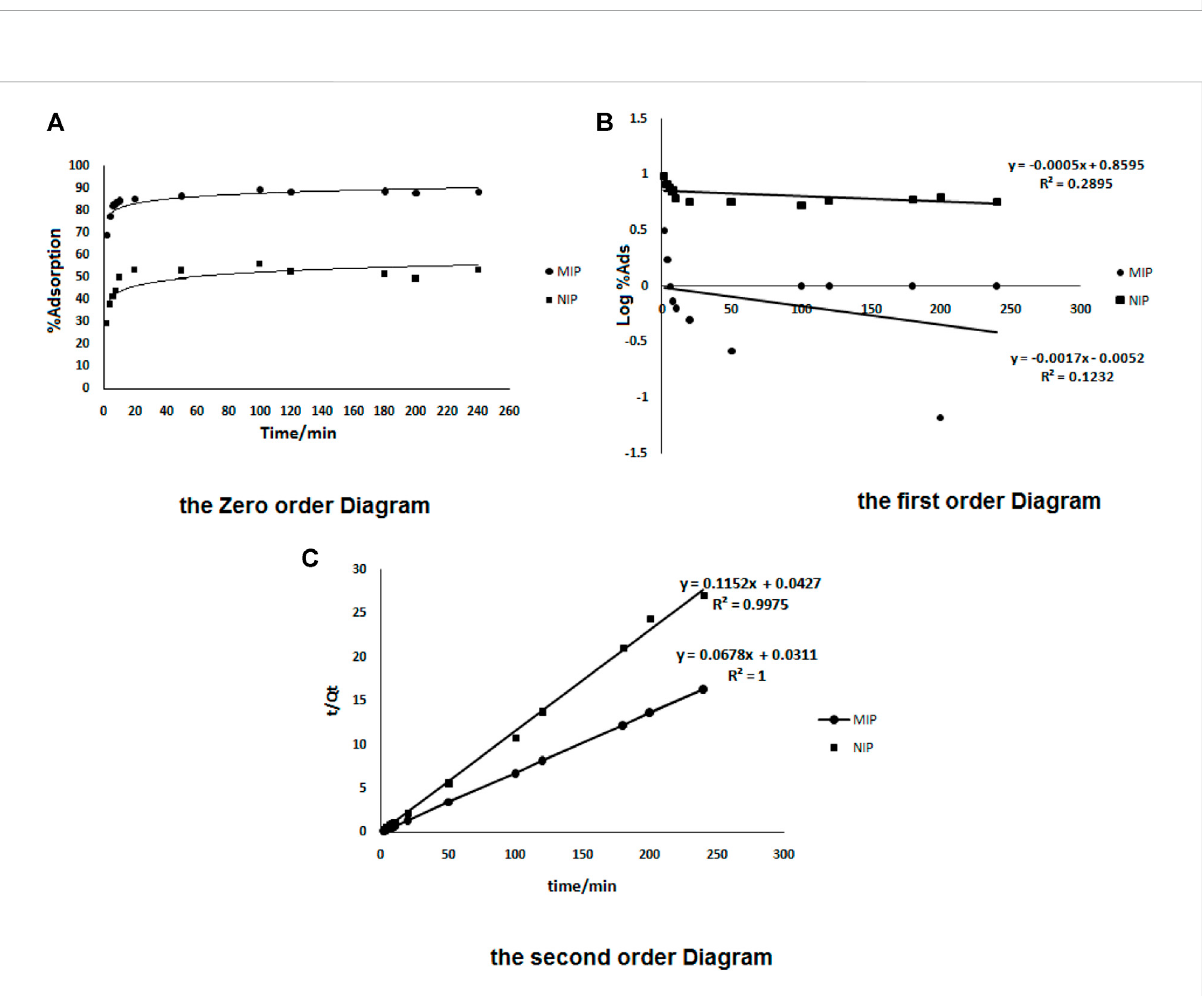
FIGURE 5 The zero order (A) , the fi rst order (B) , and the second order (C) kinetics models for adsorption of oxycodone by MIP and also by NIP.